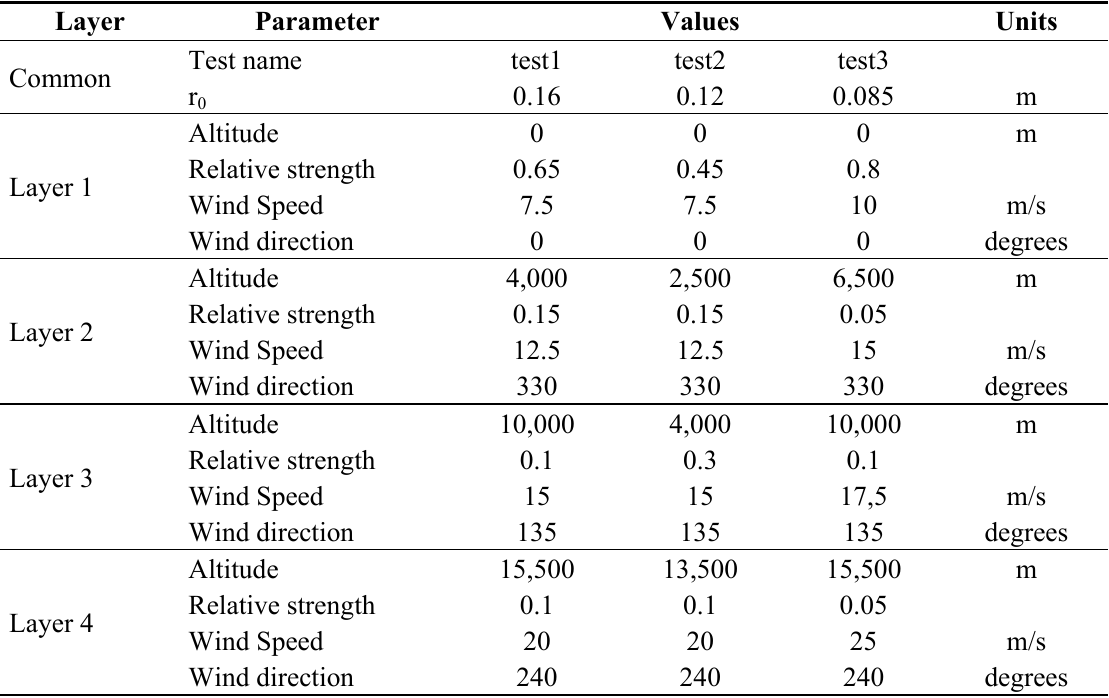
Table 2. Layer parameters of the three test